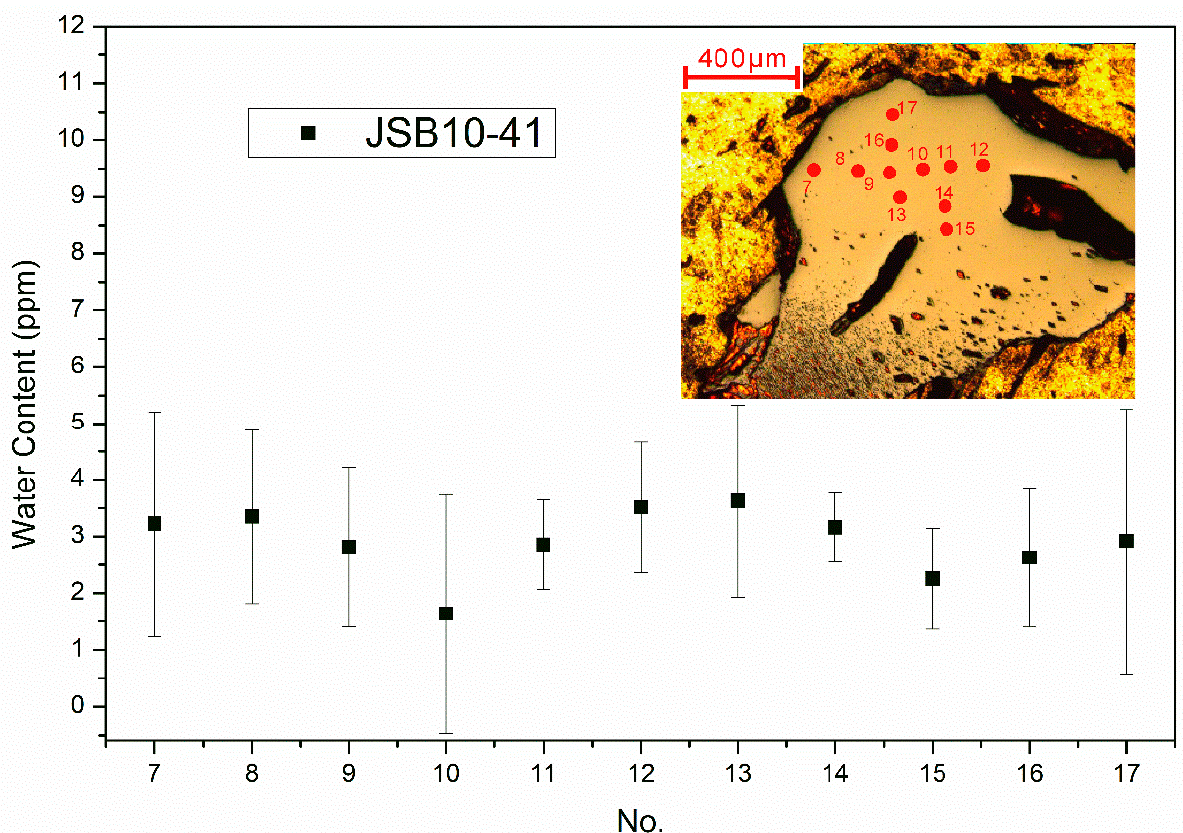
Figure 2. Analysis profile of olivine from xenolith JSB10-41. Red dots denote the water content analysis spots.